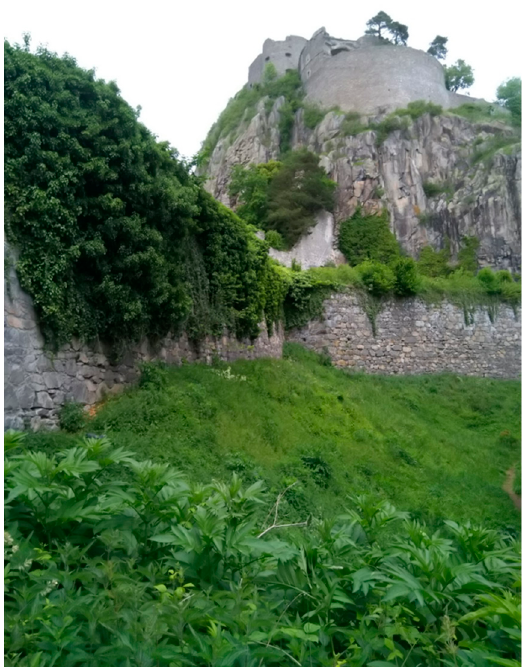
Figure 14. Castle Hohentwiel built on a Hegau volcano (Author 2020).